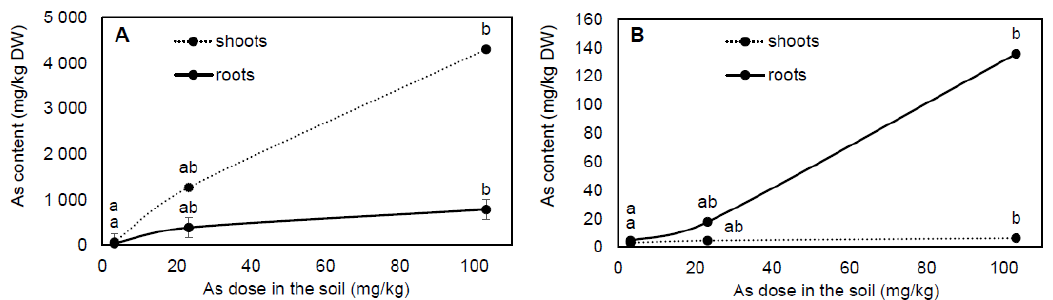
Figure 1. Effect of As treatments on shoot and root dry biomass of Pteris cretica ( A ) and Spinacia oleracea ( B ) in the pot experiment. Values represent the mean ± SE of three biological and two technical replicates per sample. Data with the same letter are not significantly different. Different letters indicate significant differences ( p ≤ 0.05) among treatments according to the Kruskal-Wallis test. The background soil pseudo-total As content was 16 mg As/kg soil. The difference between control and individual As treatments was the spiked As dose plus the 20% As extraction efficiency. Table 1. Bioaccumulation factor (BF = content in the plant part/content in the soil) and translocation factor (TF = content in the shoots/content in the roots) of Pteris cretica and Spinacia oleracea . Treatment abbreviations: control—0 mg As/kg soil; As20—20 mg As/kg soil; As100—100 mg As/kg soil. Values represent the mean ± SE of three biological and two technical replicates per sample. Data with the same letter are not significantly different. Different letters indicate significant differ- ences ( p ≤ 0.05) among treatments according to the Kruskal -Wallis test.